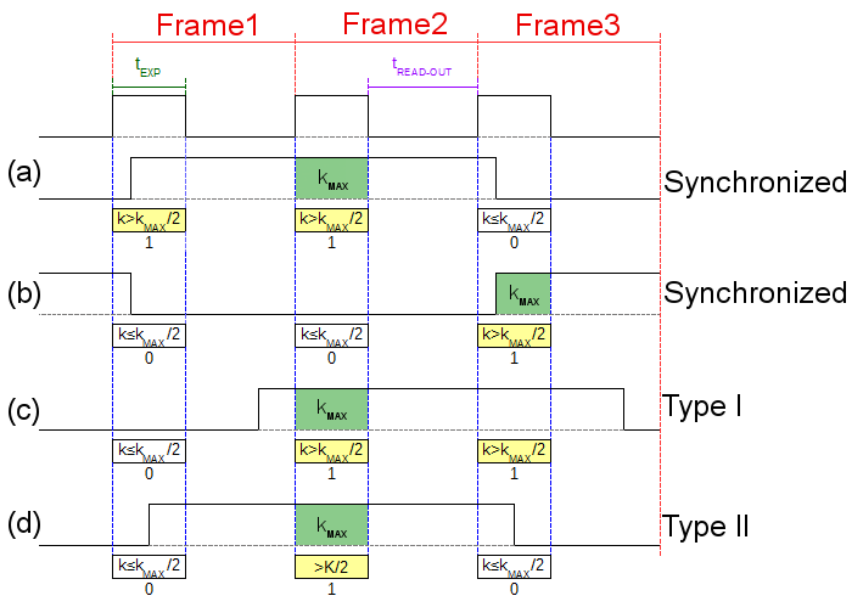
Figure 17. Synchronizing procedure. ( a ) The average pixel value of the second frame is k max , therefore the first two frames are decoded as “1” ( k > k max /2) and the third is decoded as “0” ( k < k max /2), so the signal is synchronized with the camera and no process is needed. ( b ) The average pixel value of the third frame is k max , therefore the first two frames are decoded as “0” ( k < k max /2) and the third is decoded as “1” ( k > k max /2), so the signal is synchronized with the camera as in case (a). ( c ) The average pixel value of the second frame is k max , therefore the first frame is decoded as “0” ( k < k max /2) and the other ones are decoded as “1” ( k > k max /2), so the signal is not synchronized with the camera and type I process is needed; the first frame is discarded in order to synchronize the signal. ( d ) The average pixel value of the second frame is k max , therefore the first and third frames are decoded as “0” ( k < k max /2) and the second is decoded as “1” ( k > k max /2), so the signal is not synchronized with the camera and type II process is needed; the emitter restart the